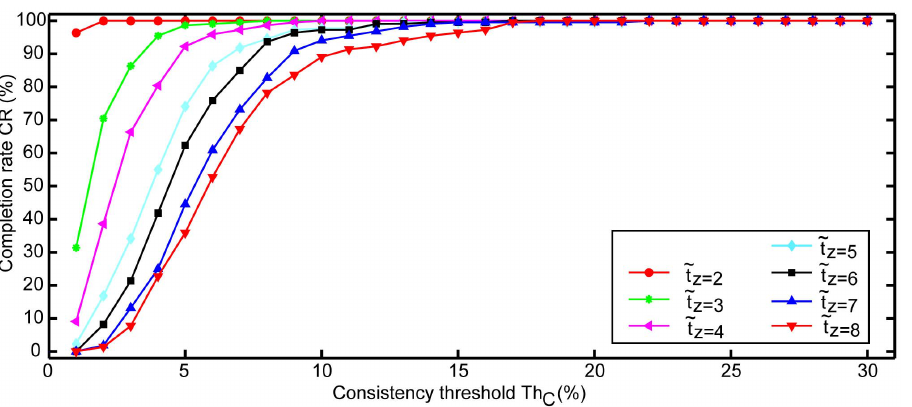
Figure 7. Completion rate CR against consistency threshold Th C for the different number of time intervals in a set (z).